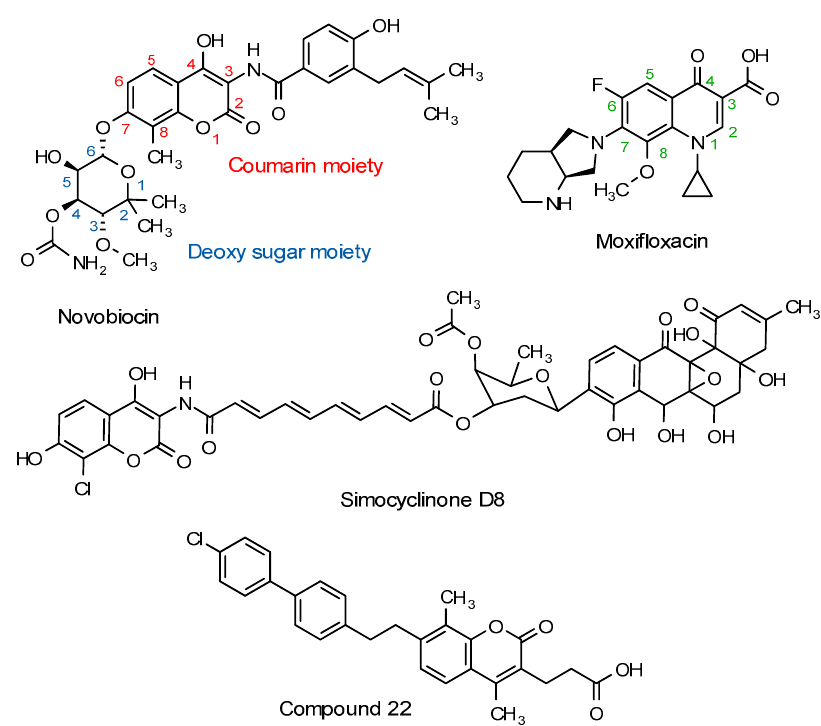
Figure 1. Molecular structure of novobiocin, moxifloxacin, simocyclinone D8 and compound 22 as examples of antimicrobial coumarin derivatives.